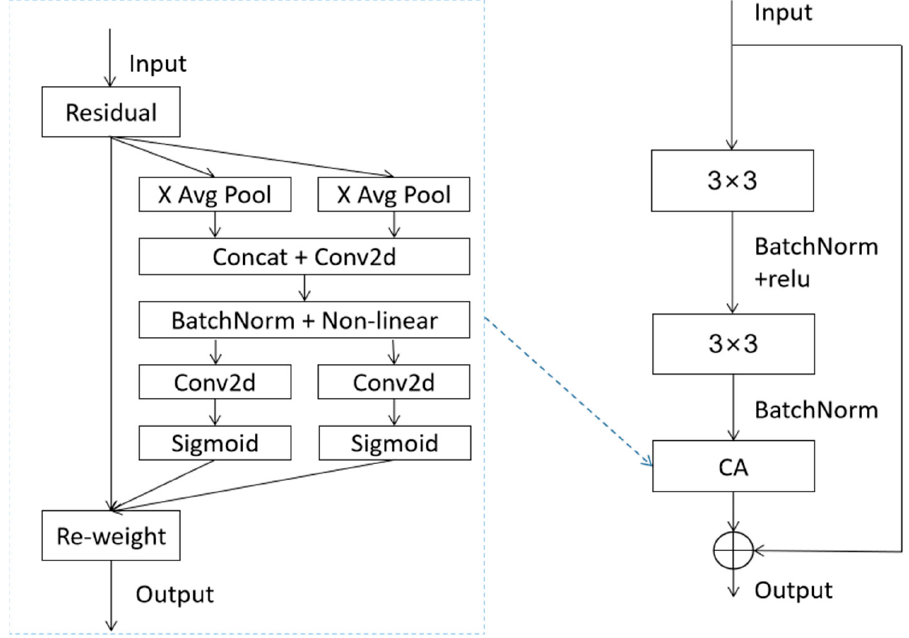
Figure 2. CA residual module. The CA is inserted into the residual block. Note: “X Avg Pool” and “Y Avg Pool” refer to 1D horizontal global pooling and 1D vertical global pooling, respectively.